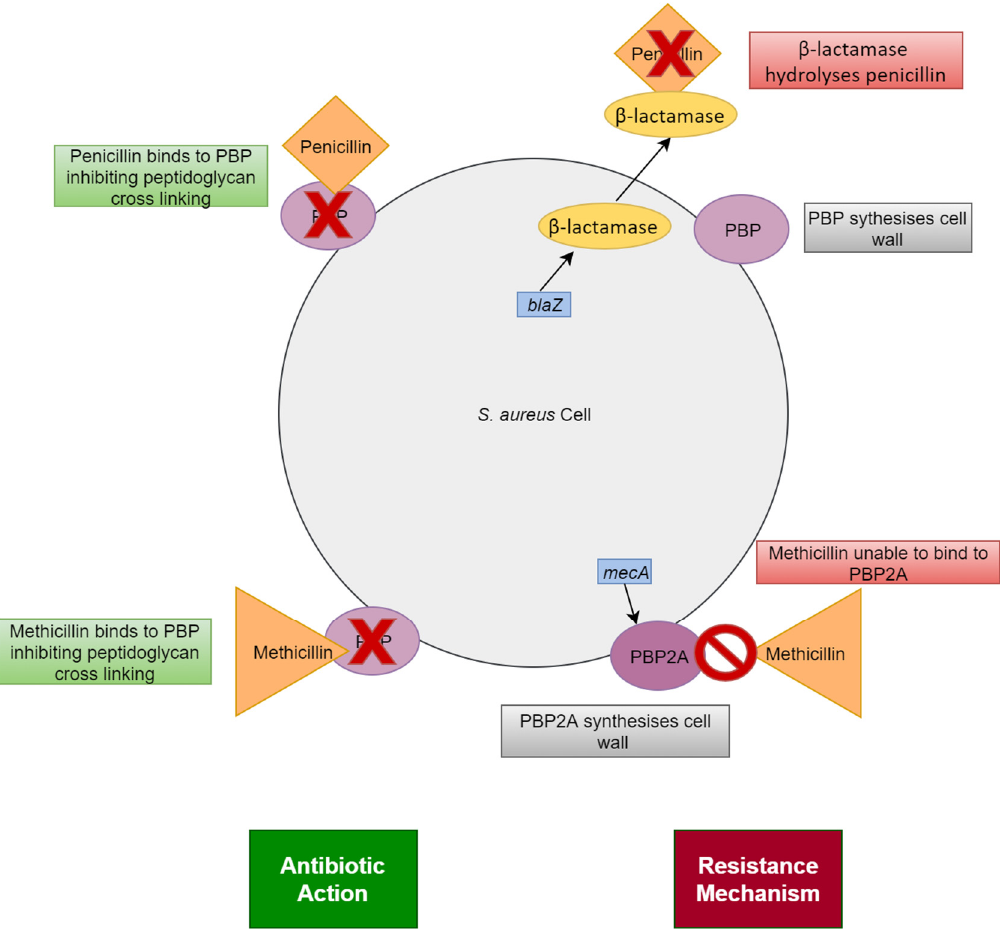
Figure 3. Antibiotic action of penicillin and methicillin against S. aureus and resistance mechanisms used by S. aureus against penicillin and methicillin.